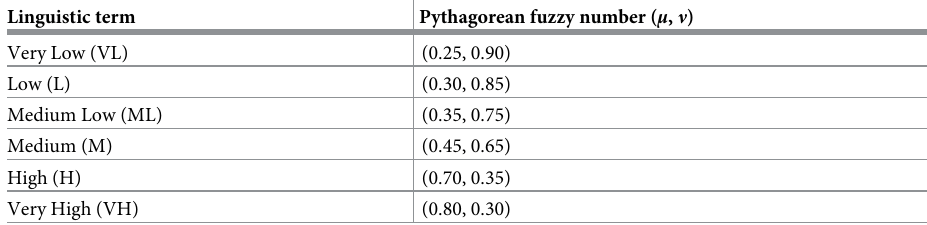
Table 1. Linguistic scale for Pythagorean fuzzy numbers